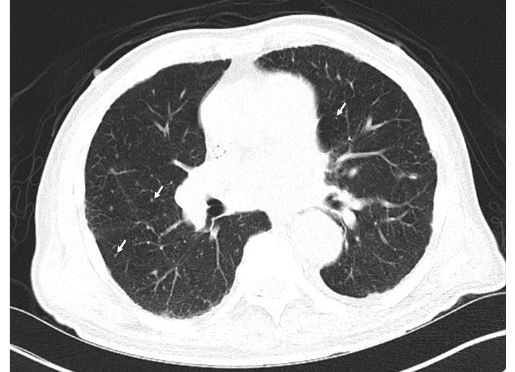
Figure 2: CT scan revealed the diffuse of tiny bilateral pulmonary nodules (arrows) secondary to granulomatous disease particularly with large calcified granulomas with mediastinal and hilar lym- phadenopathy. There was evidence of pulmonary arterial hyperten-